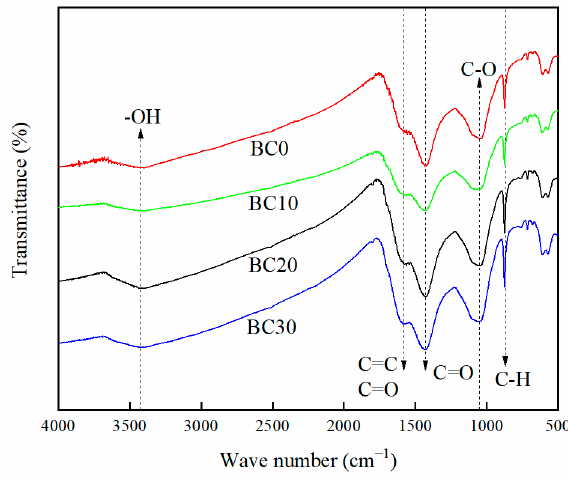
Figure 3. Comparison of FTIR spectra plotted for biochars derived from HS-PP blends.